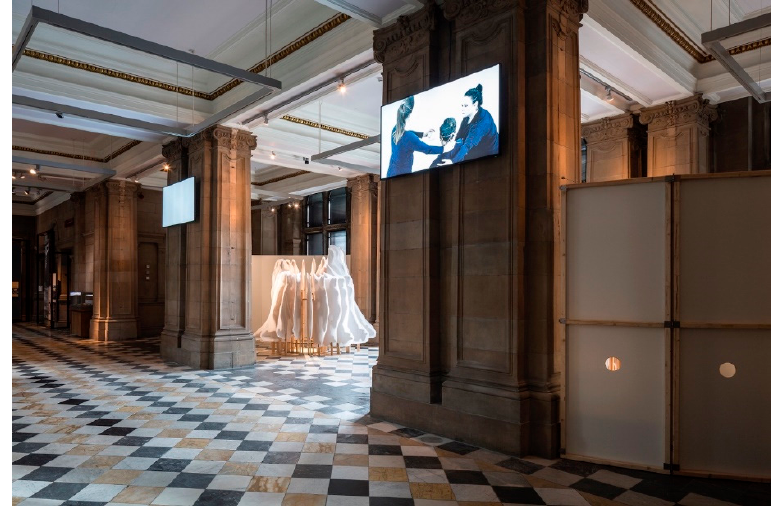
Figure 3. Christine Borland, “I say nothing”, 2018. MDF, paint, glassine, timber, chipboard, video, porcelain, acrylic, paper. Image Courtesy of Christine Borland.